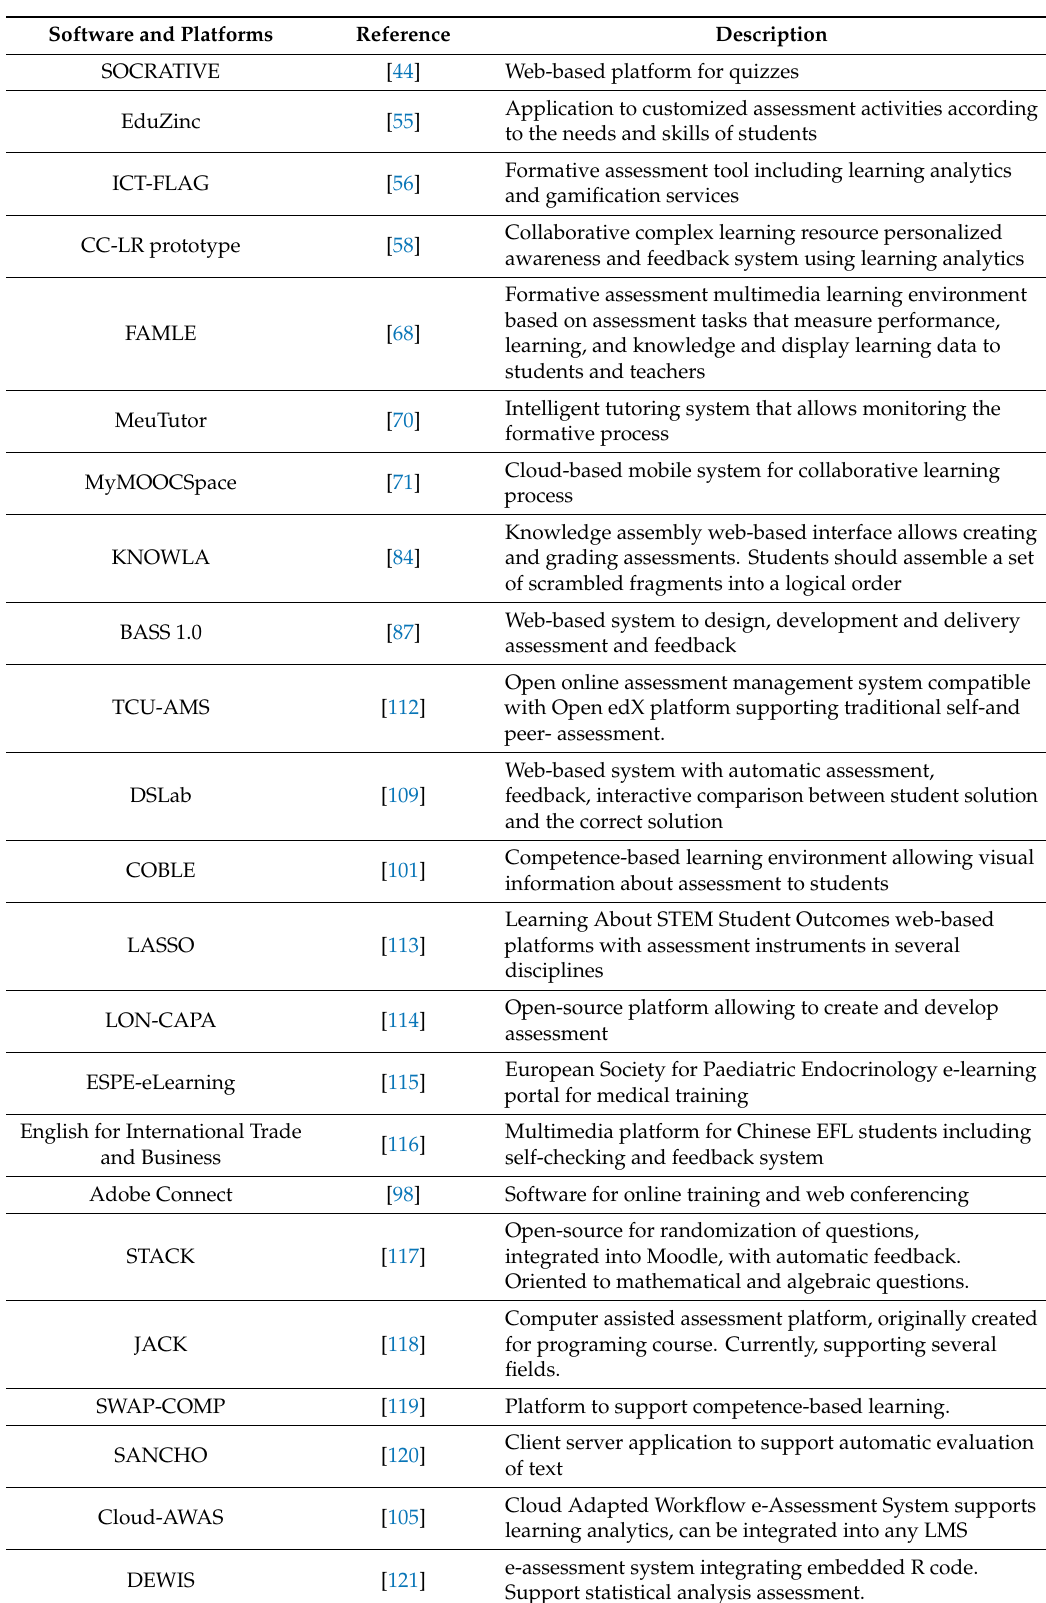
Table 4. Software and platforms that support ICT-mediated